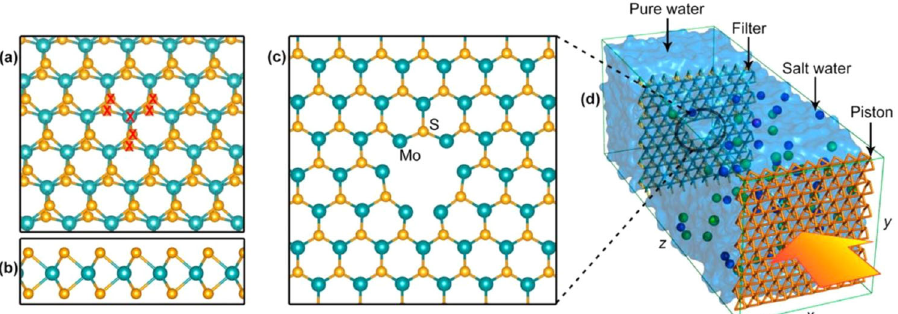
Fig. 7 Illustration of the RO membrane set up for water desalination. Reproduced with permission from ACS Nano 10, 2 (2016). Copyright 2016 American Chemical Society 9